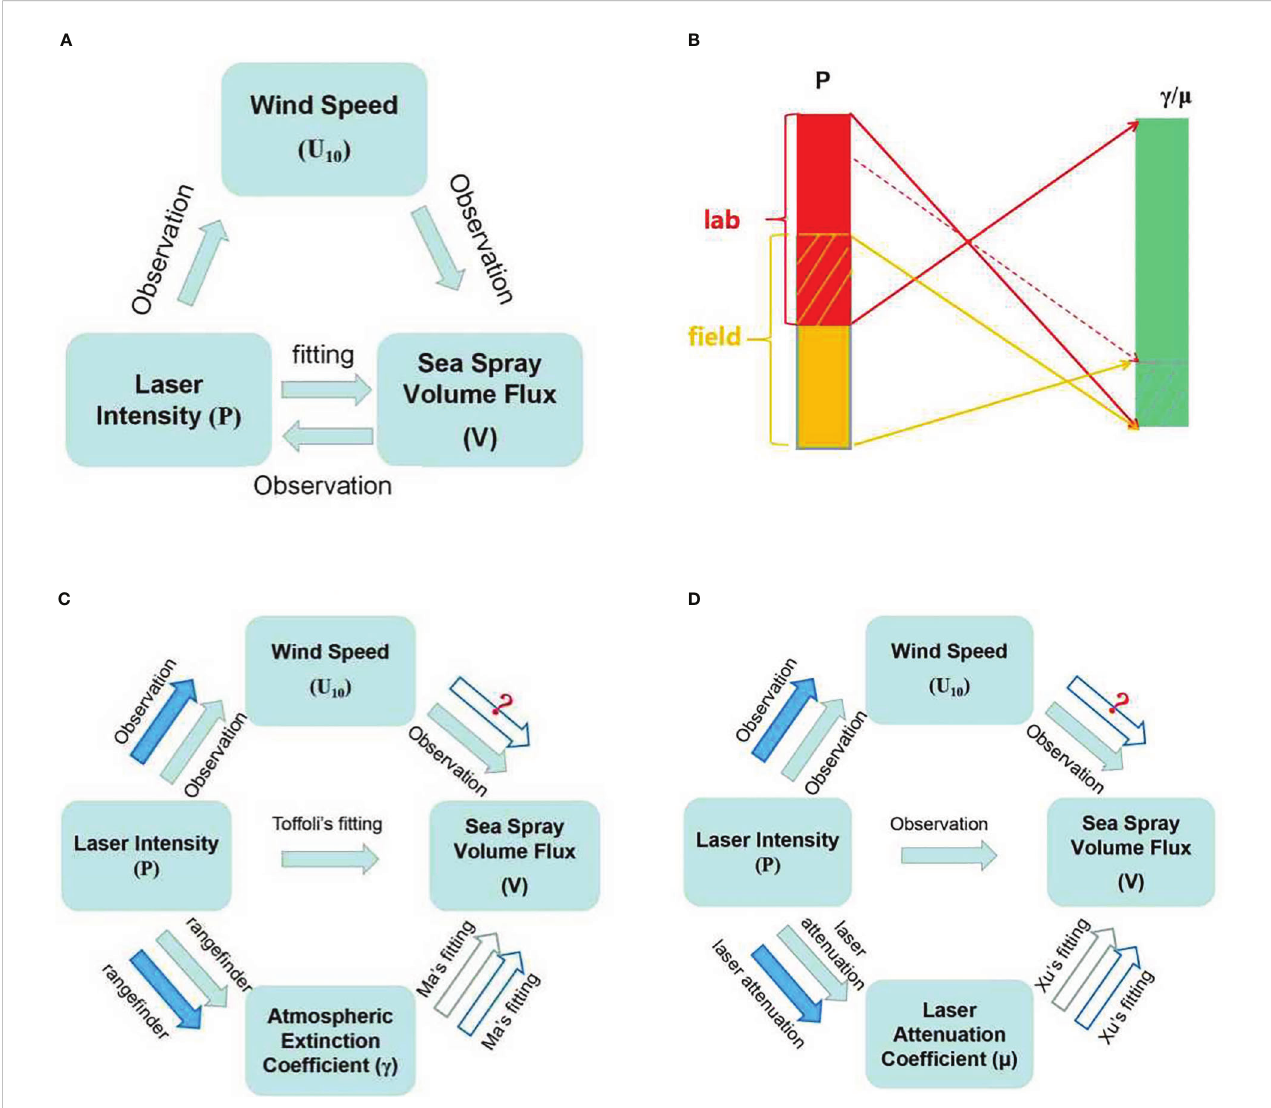
FIGURE 1 Relationships of laser intensity, sea spray volume fl ux, and wind speed for laboratory experiment in Toffoli et al. (2011) (A) ; Sketch of mapping of laser intensity onto the environment variable ( g in Ma et al., 2020, or m in Xu et al., 2021) (B) ; The approaches to estimating spray volume fl ux by laser intensity, Ma et al. (C) , and Xu et al. (D) . For fi eld observations, both Ma et al. and Xu et al. mapped laser intensity onto an environment variable fi rst and then estimated the spray volume fl ux from laser intensity with the help of the environment variable. Solid arrows in ( A , C, D) indicate that an analytic relationship between the two variables has been established, while hollow arrows indicate that the relationship between the two variables has not been established. Blue arrows for fi eld observations and green arrows for laboratory observations. Hollow arrow with question mark is the major relationship to be established in the corresponding